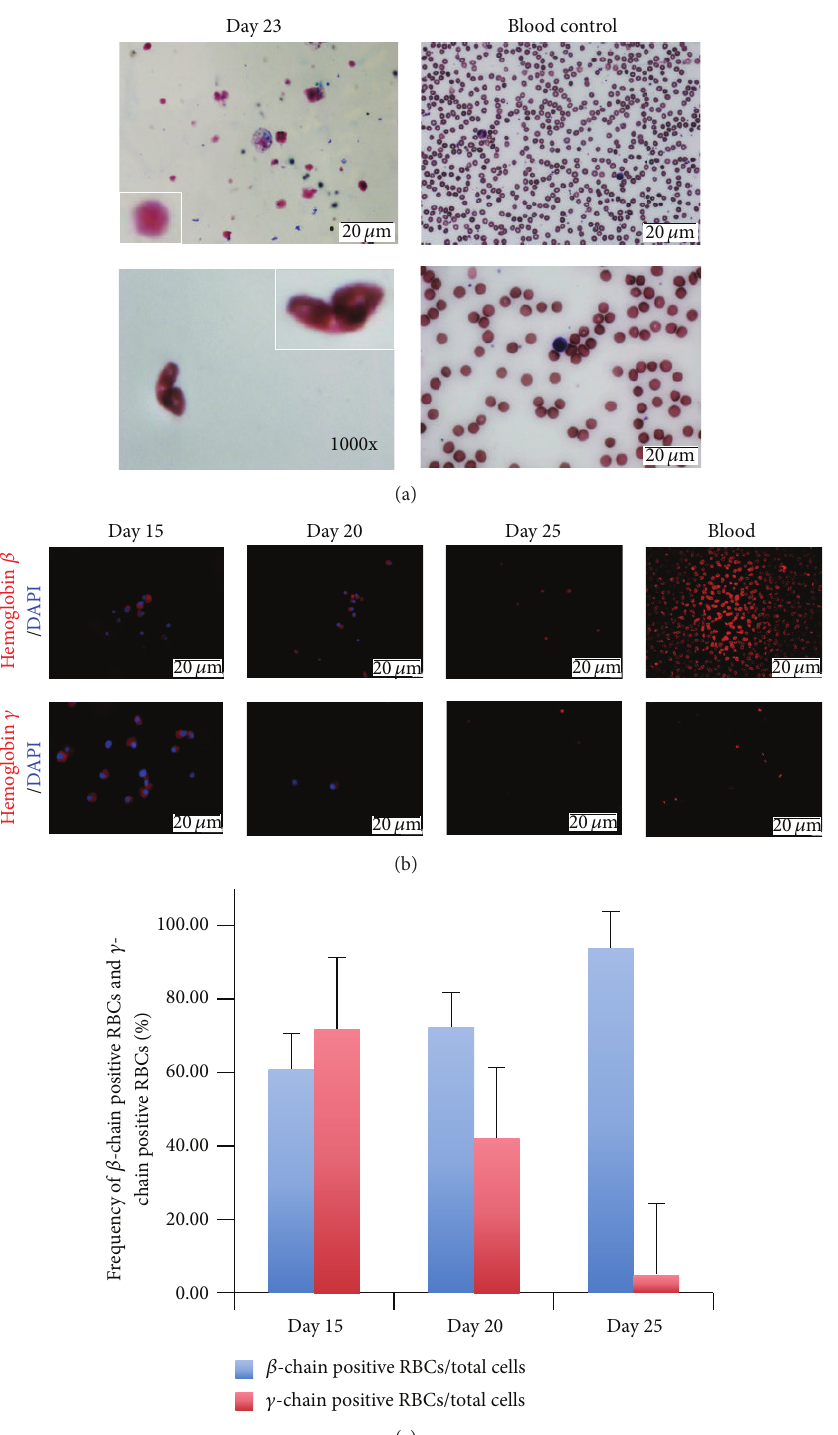
Figure 5: Enucleation and maturation of hHFMSC-derived erythroblasts in vitro . (a) hHFMSC-derived erythrocytes were cytospun and stained with Wright-Giemsa dye and compared with red blood cells from human blood. Scale bar represents 20 𝜇 m. (b) Cell stained with monoclonal antibody against hemoglobin 𝛽 -chain (left) or 𝛾 -chain (right). (c) The frequencies of generated RBCs expressing 𝛽 -chain and 𝛾 -chain hemoglobin were presented by the average ratios of positive cells to total cells from more than 3 fields under